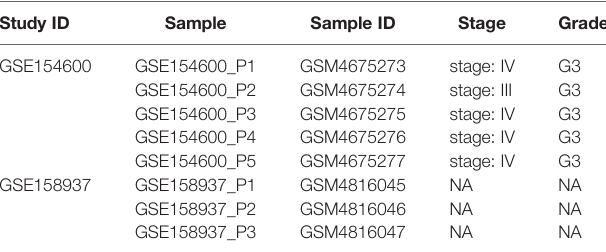
TABLE 1 | OV patient information (single-cell